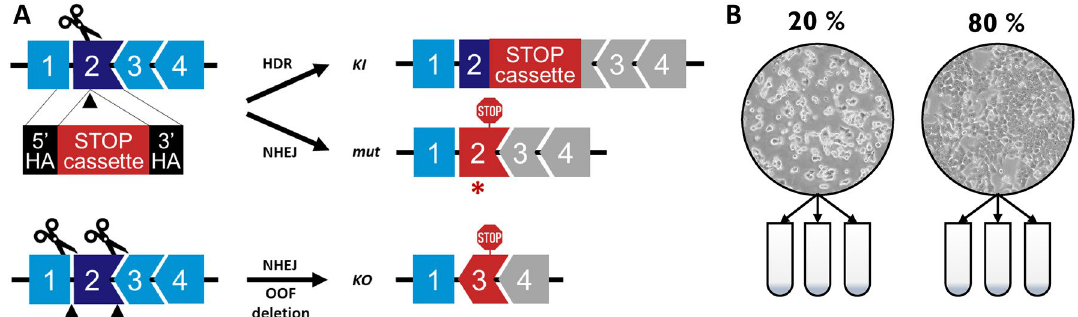
Figure 1. Sample preparation: ( A ) A schematic illustration of the strategies for CRISPR/Cas9 mediated generation of constitutive gene knockouts in HCT116 cells. Upper panel: Single guide RNA targeting an early exon of a gene of interest will generate a double-strand break (DSB). In the presence of a DNA repair donor containing a promoterless gene trap (stop) cassette flanked with 5’ and 3’ in-frame homology arms (HA) two DSB repair outcomes are possible: (1) homology-directed repair (HDR) will result in an in-frame knockin (KI) of the stop cassette leading to gene inactivation or (2) the non-homologous end joining (NHEJ) repair will generate INDEL mutation (mut, represented by an asterisk), leading to a premature stop codon (red stop sign). Lower panel: targeting introns flanking an early critical exon with two guide RNAs will lead to an out-of- frame (OOF) deletion of the critical exon. Following the NHEJ-mediated repair, a premature stop codon (red stop sign) will be created in the downstream coding sequence, leading to gene knockout (KO). ( B ) KO cell lines were grown to densities of 20% and 80% confluency and samples were collected in triplicates.